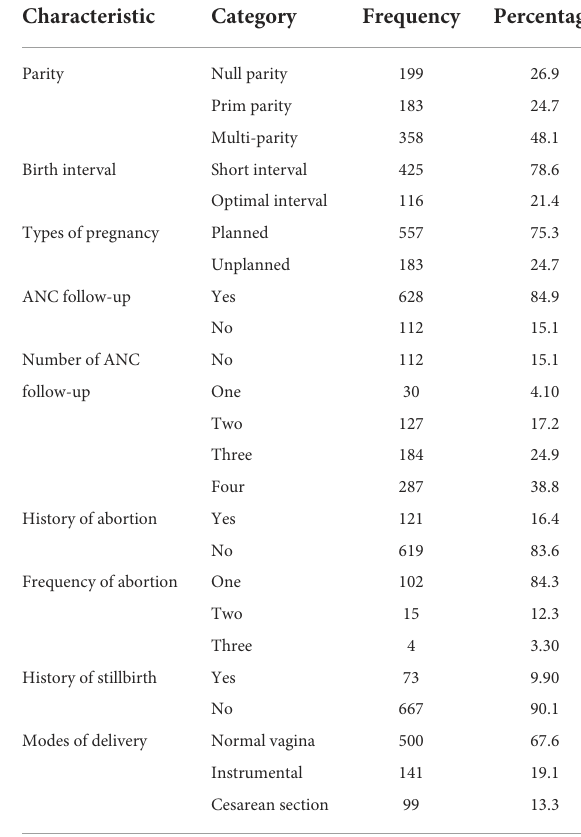
TABLE 2 Reproductive health-related characteristics of respondents in public hospitals of North Shewa zone, Oromia region, Central Ethiopia,